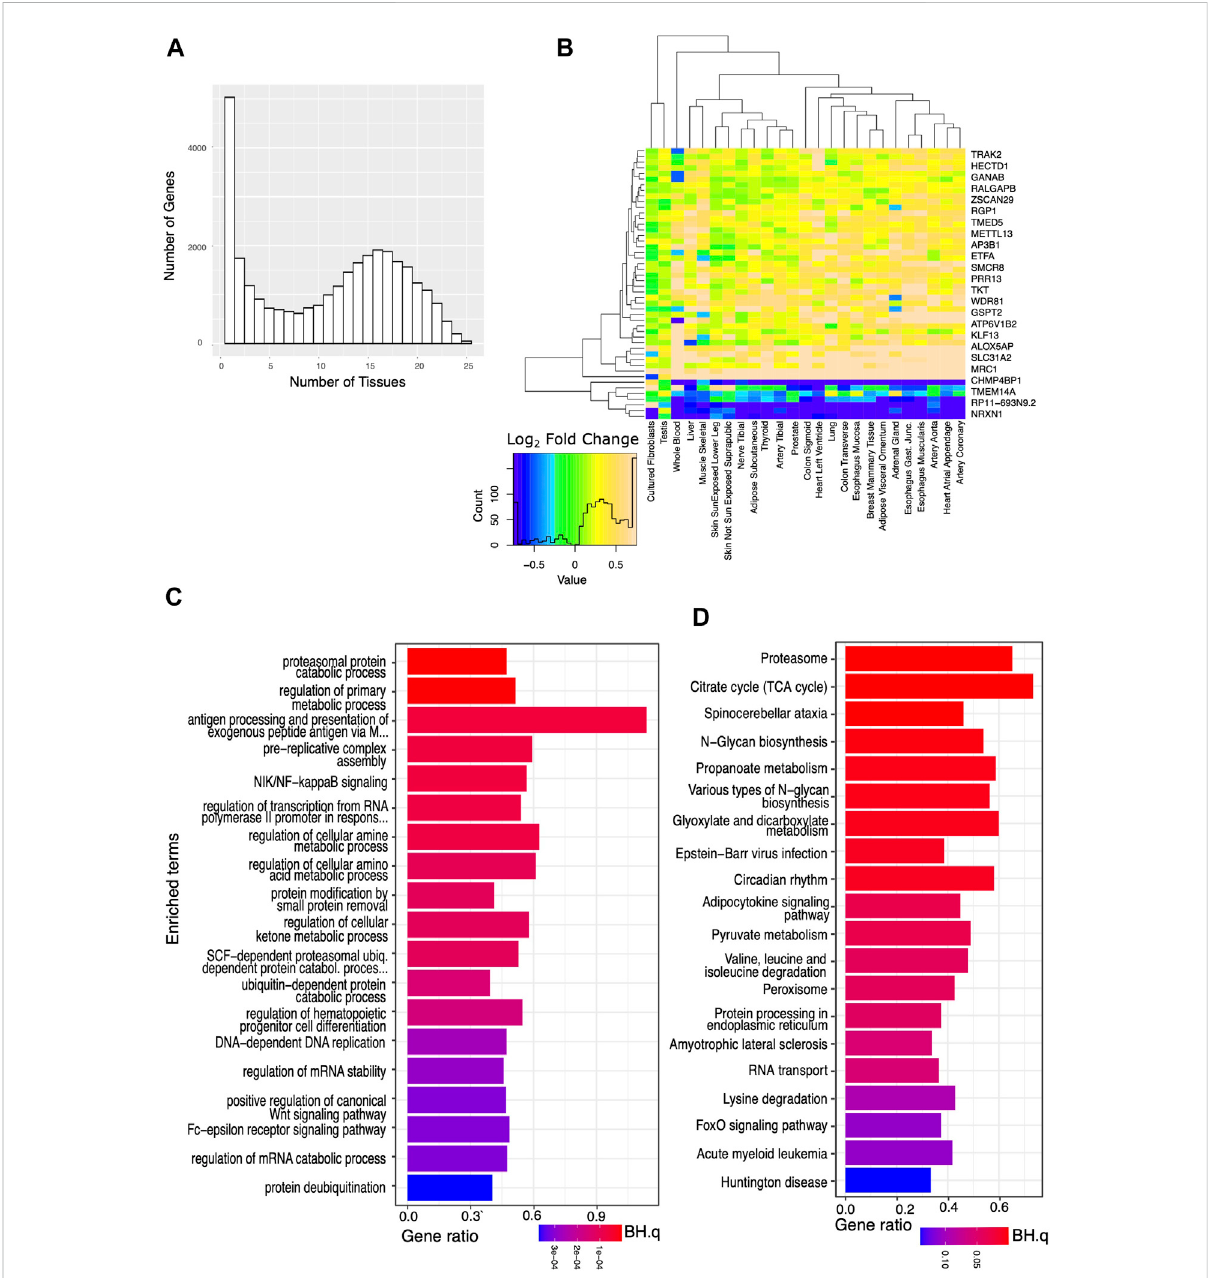
FIGURE 2 Analysis of genes signi fi cantly affected by critical care across a wide variety of tissues. We analyzed the set of genes that were signi fi cantly (BH.q < 0.05) differentially expressed in the IC and AD groups. (A) Histogram of the number of tissues for which any given gene meets these criteria. (B) Log 2 fold changes of genes signi fi cantly differentially expressed between AD and IC groups (in 25 tissues) shown across tissue type. Transcripts appear to be consistently up or down regulated across tissue type. (C) GO BP pathways and (D) KEGG pathways enriched in IC differentially expressed genes that met the above criteria in ≥ 75% of tissues. Note appearance of circadian rhythm among the most signi fi cantly ( p < 0.0003, BH. q < 0.01) enriched